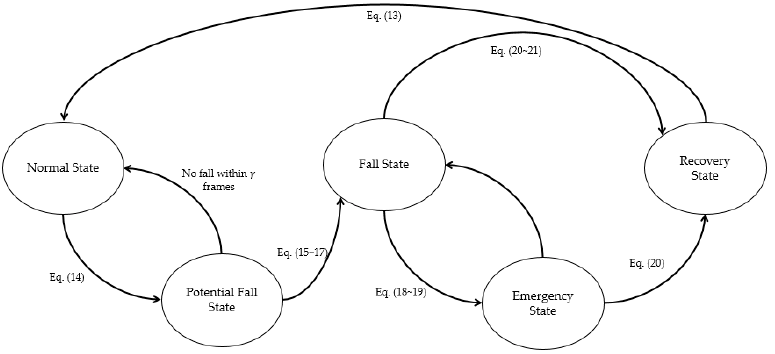
Figure 15. State transition model of the proposed fall detection algorithm.